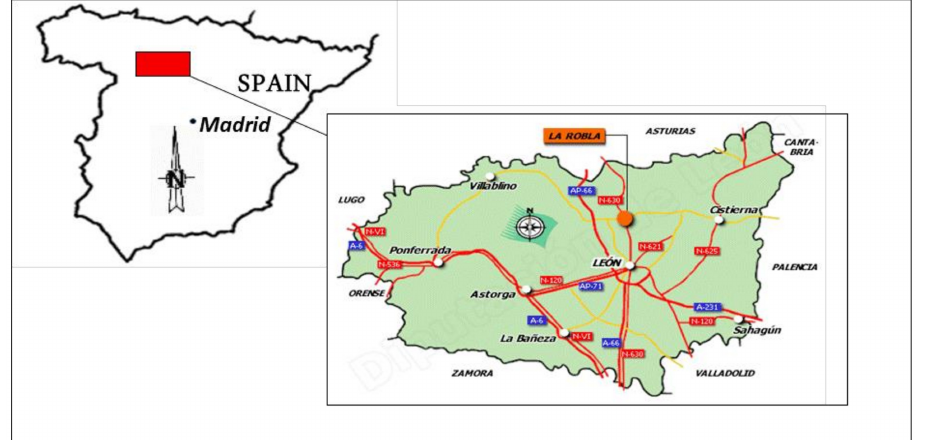
Figure 1. Location map of the study area.